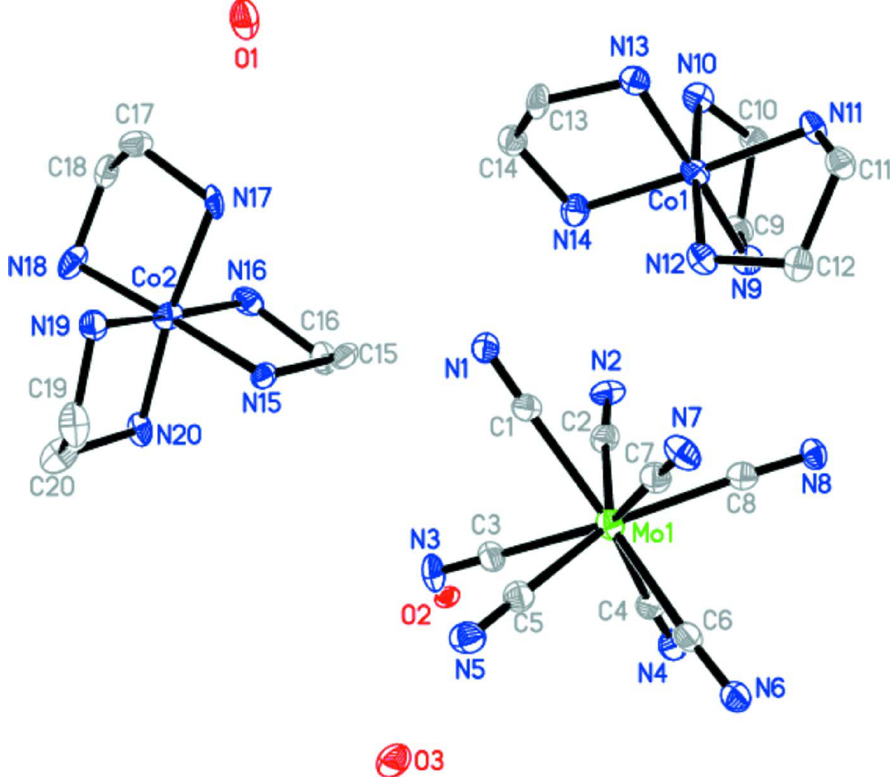
ORTEP view of the title compound showing 30% probability probability displacement ellipsoids and atom labelling scheme. Hydrogen atoms have been omitted for clarity. The occupancies of the water oxygen atoms are 0.4 (O1), 0.3 (O2), 0.3